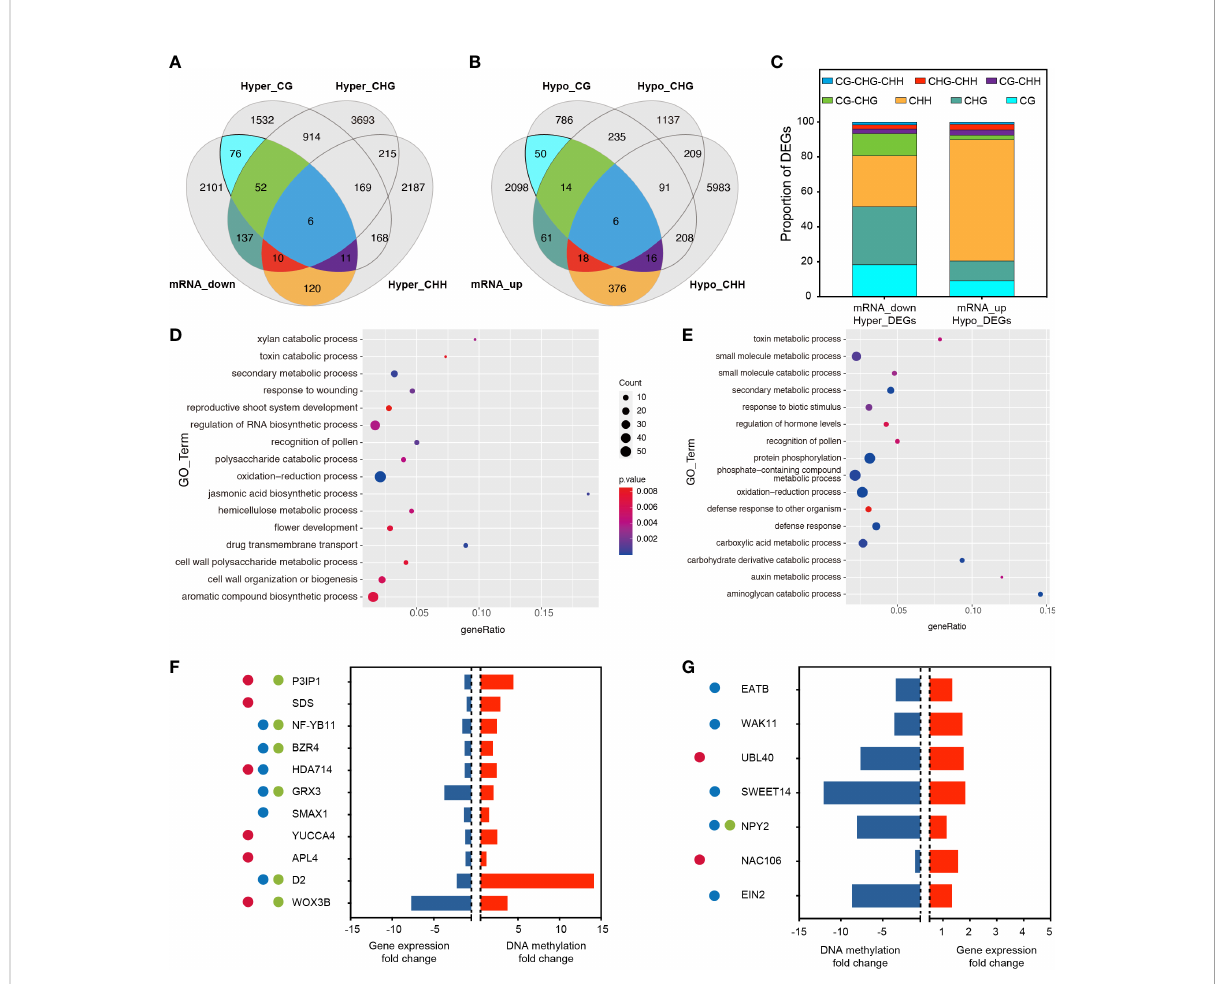
FIGURE 3 Association analysis of genes with changes in DNA methylation and transcript abundance. (A) Venn diagram showing the association between transcriptionally down-regulated DEGs and the three hypermethylated types of DMGs. (B) Venn diagram showing the association between transcriptionally up-regulated DEGs and the three hypomethylated types of DMGs. (C) Proportion of overlapping DMGs in different methylation contexts. (D) GO analysis of overlapping DMGs in mRNA_down and Hyper_DEG S . (E) GO analysis of overlapping DMGs in mRNA_up and Hypo_DEG S . (F) After RGSV infection of rice, most of these genes were associated with fertility ( ● ), plant height ( ● ), and tillering ( ● ), and these genes were down-regulated in the transcriptome (blue bars) while remaining hypermethylated (red bars). P3IP1 (LOC_Os02g33680); SDS (LOC_Os03g12414); NF-YB11 (LOC_Os08g07740); BZR4 (LOC_Os02g13900); HDA714 (LOC_Os12g08220); GRX3 (LOC_Os01g13950); SMAX1 (LOC_Os08g15230); YUCCA4 (LOC_Os01g12490); APL4 (LOC_Os07g13980); D2 (LOC_Os01g10040); WOX3B (LOC_Os05g02730). (G) After RGSV infection of rice, most of these genes were associated with fertility ( ● ), plant height ( ● ), and tillering ( ● ), and these genes were up- regulated in the transcriptome (red bars) while remaining hypomethylated (blue bars). EATB (LOC_Os09g28440); WAK11 (LOC_Os02g02120); UBL40 (LOC_Os09g31031); SWEET14 (LOC_Os11g31190); NPY2 (LOC_Os06g08550); NAC106 (LOC_Os08g33670); EIN2